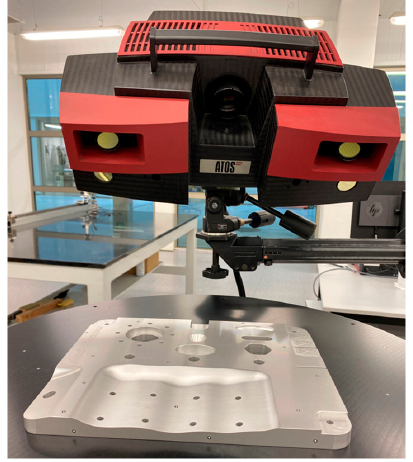
Figure 5. Automatic measurement data acquisition process set ‐ up.